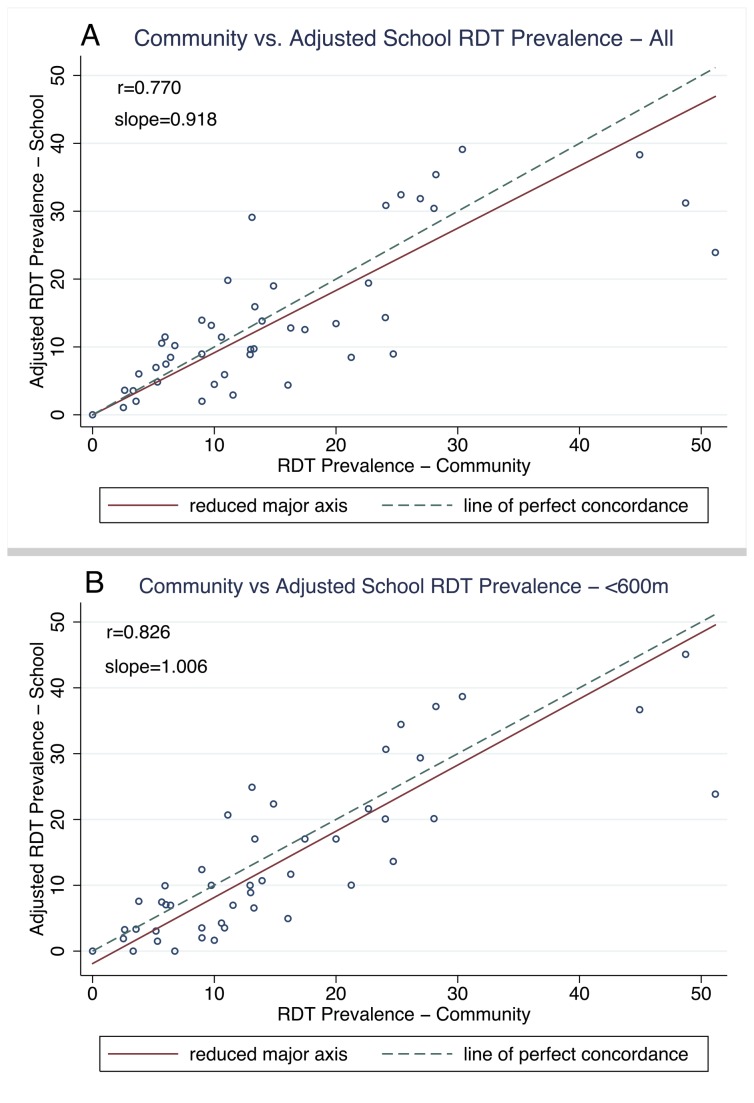
Prevalence of malaria infection: adjusted school vs. community surveys in 46 clusters by RDT and serology.Scatter plots are shown with the line of perfect concordance (x=y) and the data’s reduced major axis using total least squares regression. (A) RDT prevalence per cluster in community vs. adjusted prevalence in all school children. (B) RDT prevalence per cluster in community vs. adjusted school prevalence restricting to children residing within 600m from school.